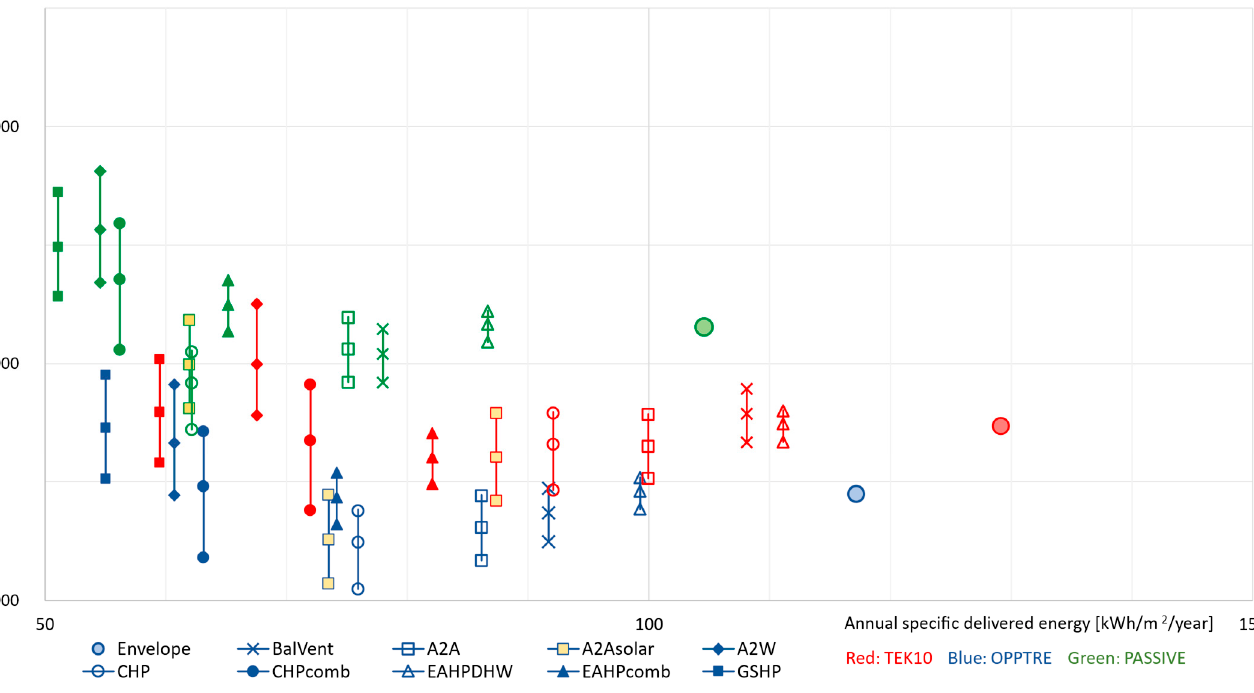
Figure A3. Specific global costs and delivered energy of the Kristiansand house with government grants included and electricity price of 2.0 NOK/kWh.